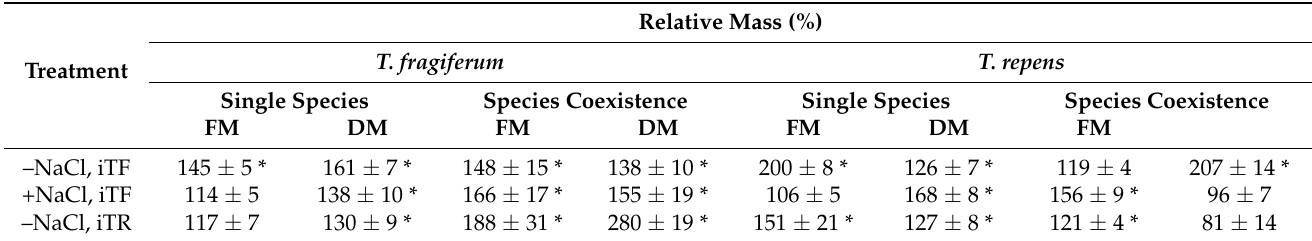
Table 7. Relative effect of inoculation with two types of rhizobia (values from the respective treatment combinations without inoculant were indicated as 100%) on total fresh and dry mass of shoots of the two Trifolium species.